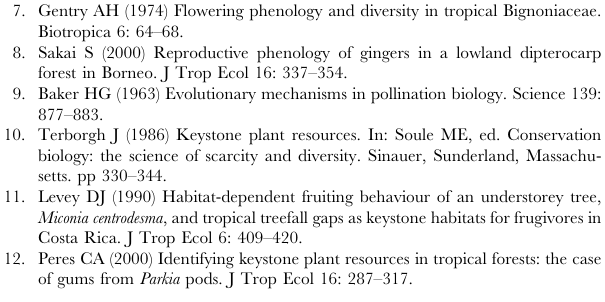
Figure S1 Map of the study area. White circles depict coffee agroforests that received the treatment of a supplemental patch of steady-state floral resources and black circles depict control farms. Table S1 List of all plant species occurring in the coffee agroforests, excluding herbaceous ground cover species. Table S2 AIC scores and likelihood ratio tests comparing models for significance of X,Y coordinates. Table S3 Model results for treatment effect, after adding X,Y coordinates, and site included as a random